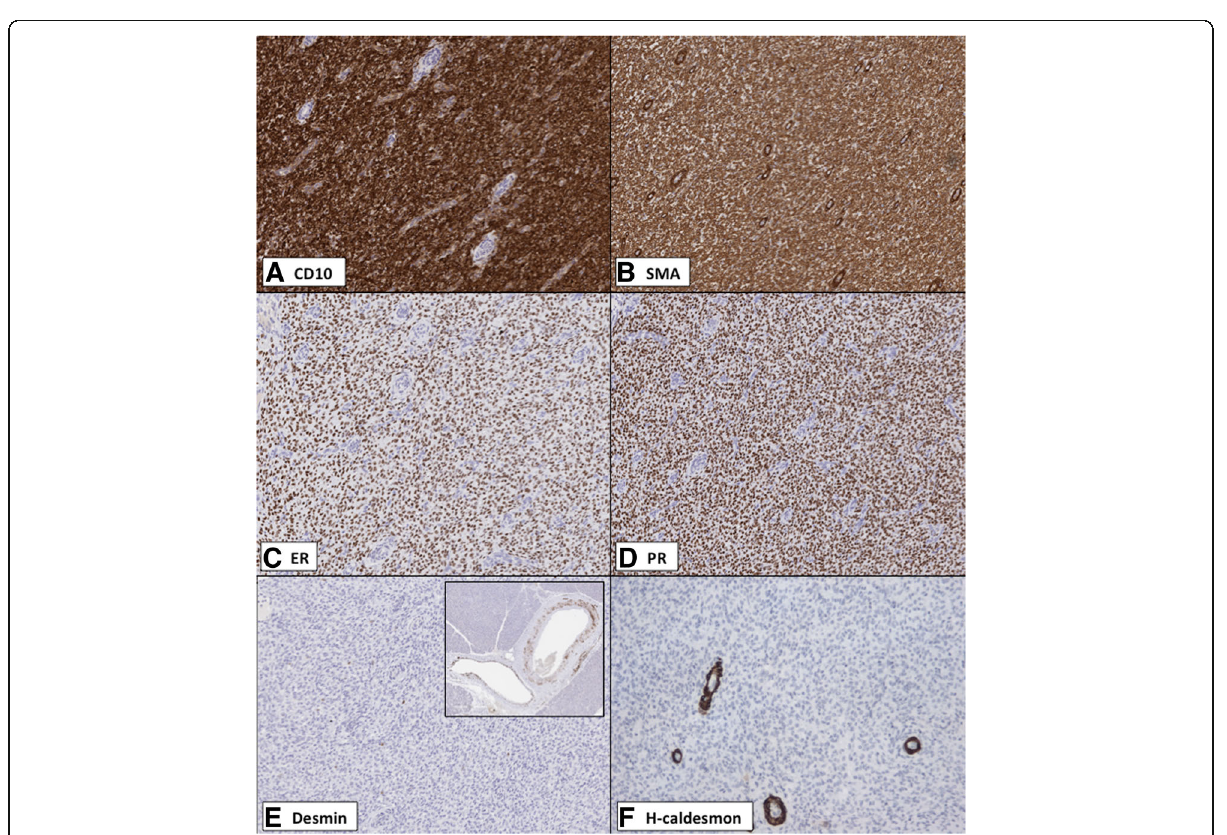
Fig. 3 Morphologically, there was a high index of suspicion that the pancreatic lesion was an ESS, and this guided the selection of immunohistochemical markers. Immunohistochemistry showed that the tumor cells of the pancreatic lesion were positive for CD10 ( a ), smooth muscle actin (SMA) ( b ), estrogen receptor (ER) ( c ) and progesterone receptor (PR) ( d ). Desmin ( e ; inset of e : vessels in pancreatic parenchyma highlighted, acting as internal controls) and h-caldesmon ( e ; arterioles highlighted, acting as internal controls) were